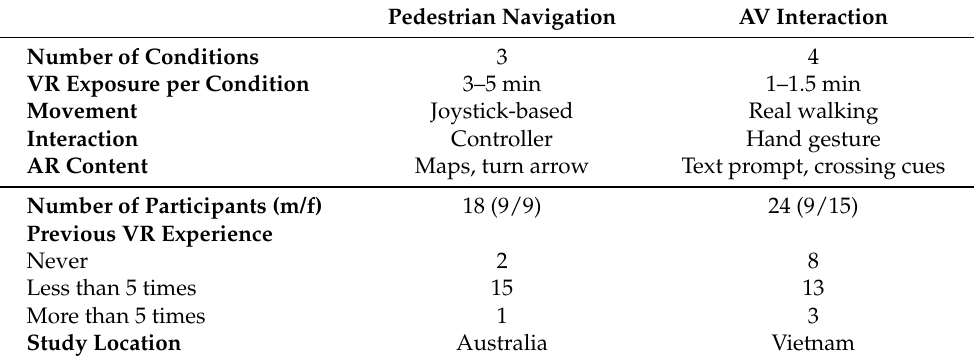
Table 1. Prototype characteristics and participants’ demographics in each case study.